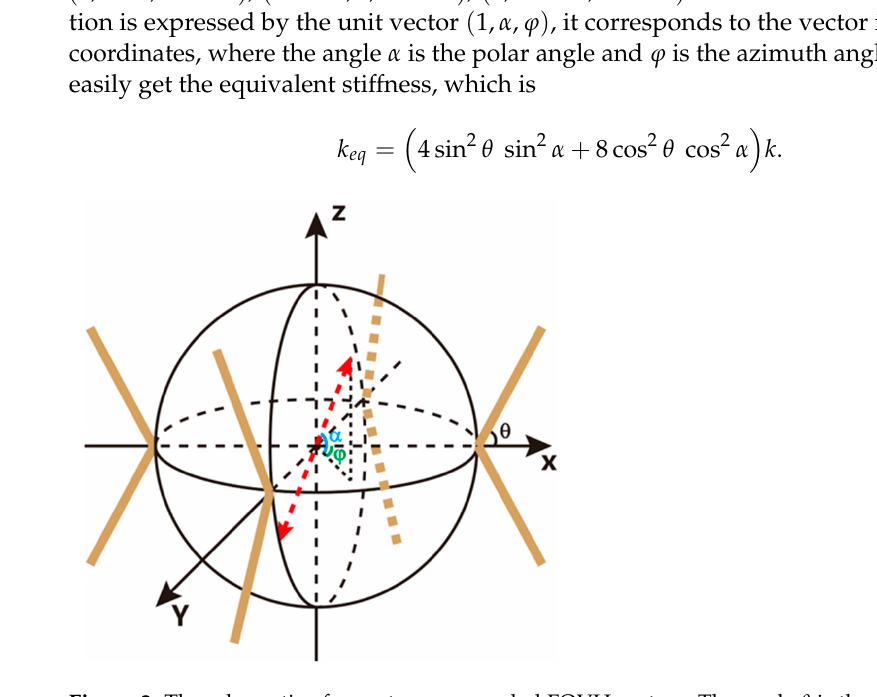
Figure 2. The schematic of one-stage suspended FOVH system. The angle θ is the suspending